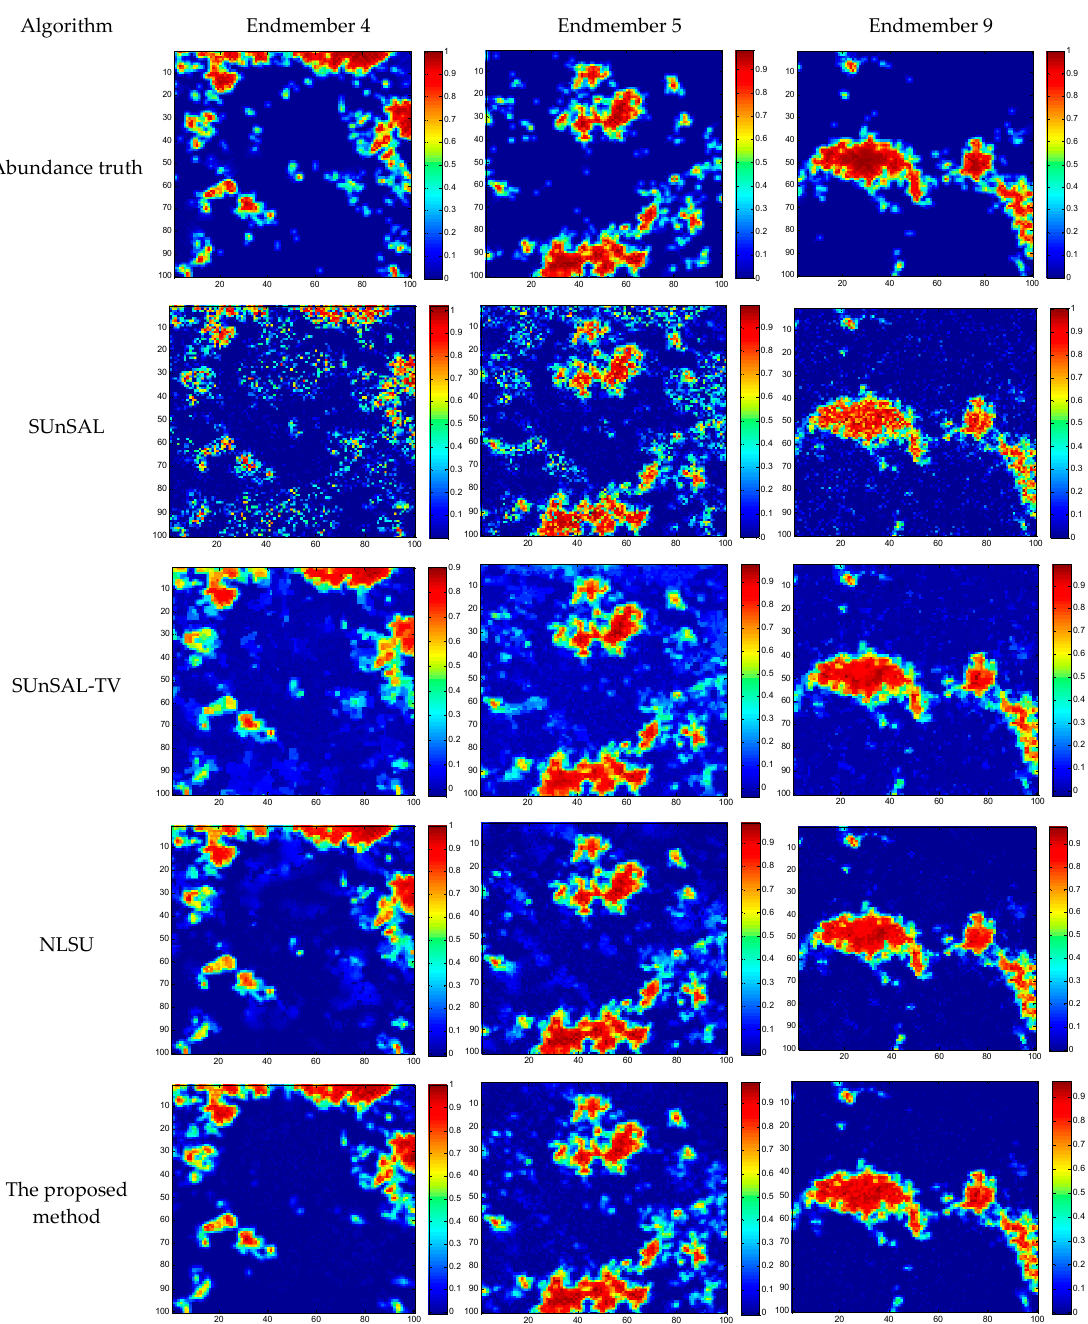
Figure 7. Estimated abundances of the endmembers for DC-2.